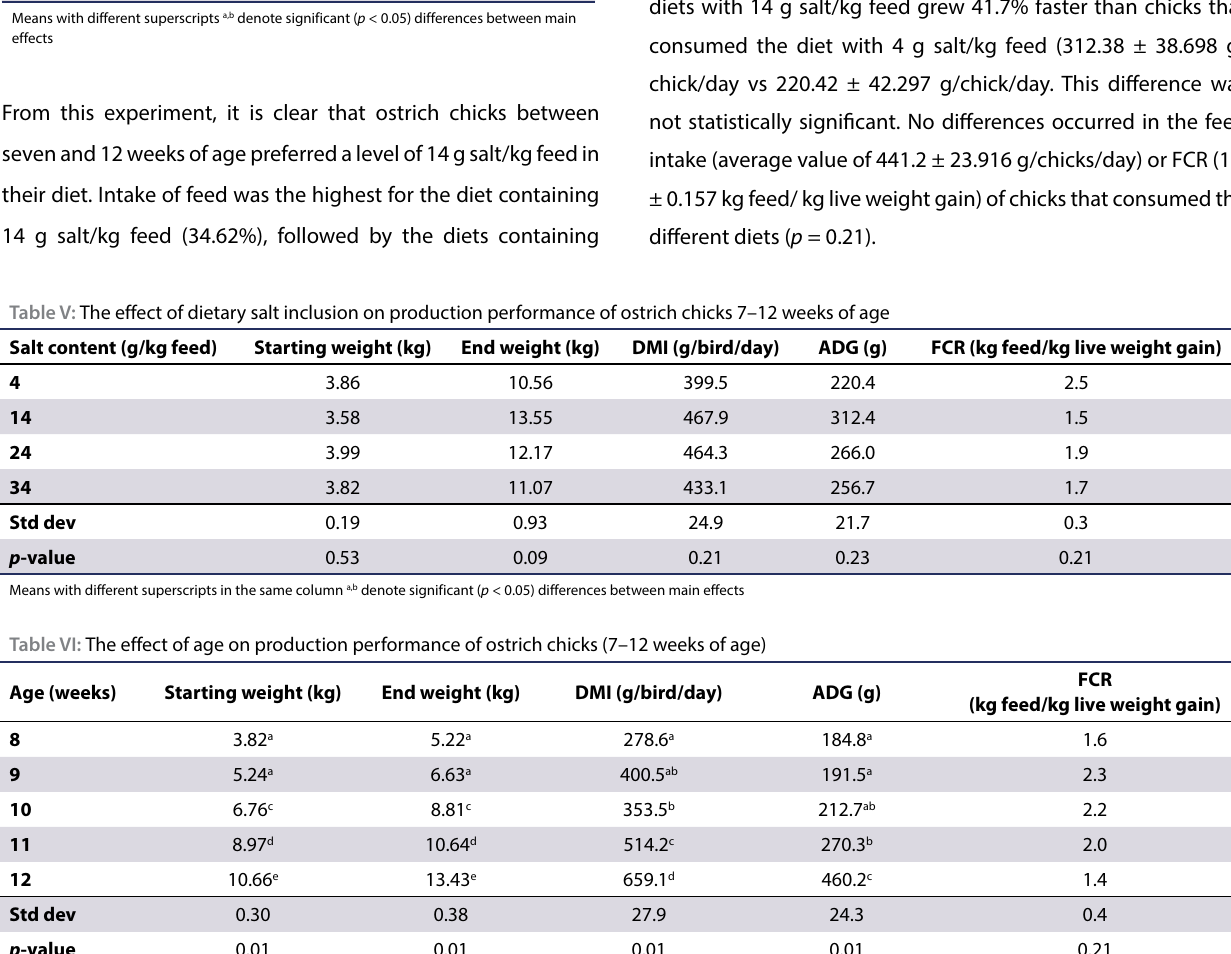
From this experiment, it is clear that ostrich chicks between seven and 12 weeks of age preferred a level of 14 g salt/kg feed in their diet. Intake of feed was the highest for the diet containing 14 g salt/kg feed (34.62%), followed by the diets containing